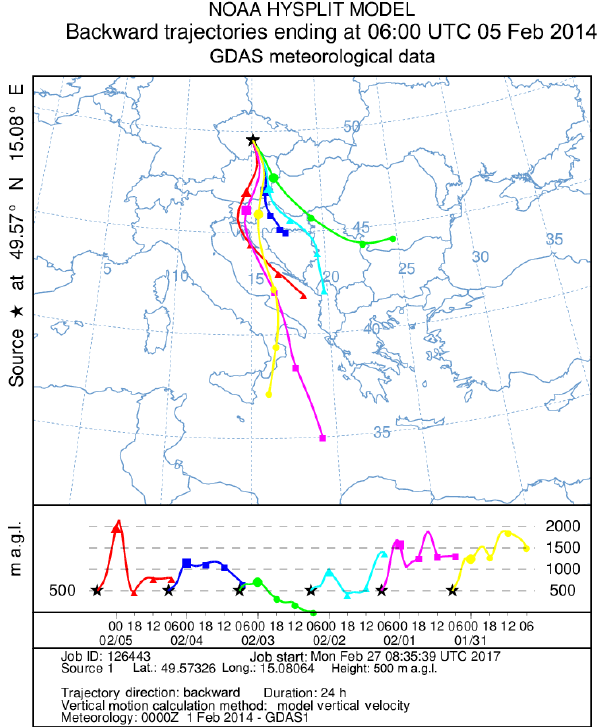
Figure 10. NOAA HYSPLIT (Stein et al., 2015) 24h backward air mass trajectories at 500ma.g.l. for the observation site from 30 Jan- uary until 5 February